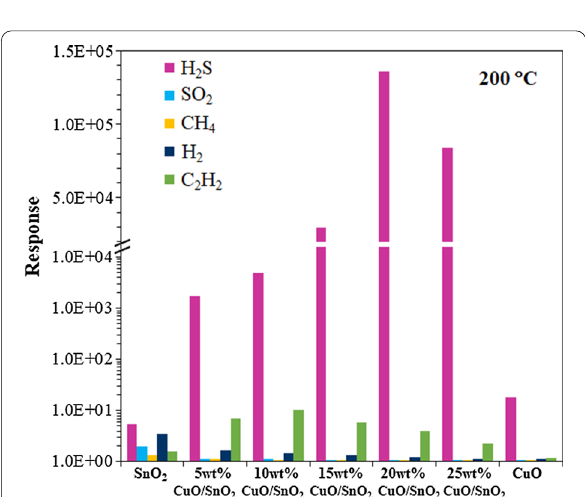
Fig. 10 Responses of CuO, SnO 2 and 5–25 wt%CuO/SnO 2 sensors toward H 2 S (10 ppm), SO 2 (200 ppm), CH 4 (1000 ppm), H 2 (1000 ppm) and C 2 H 2 (1000 ppm) at 200